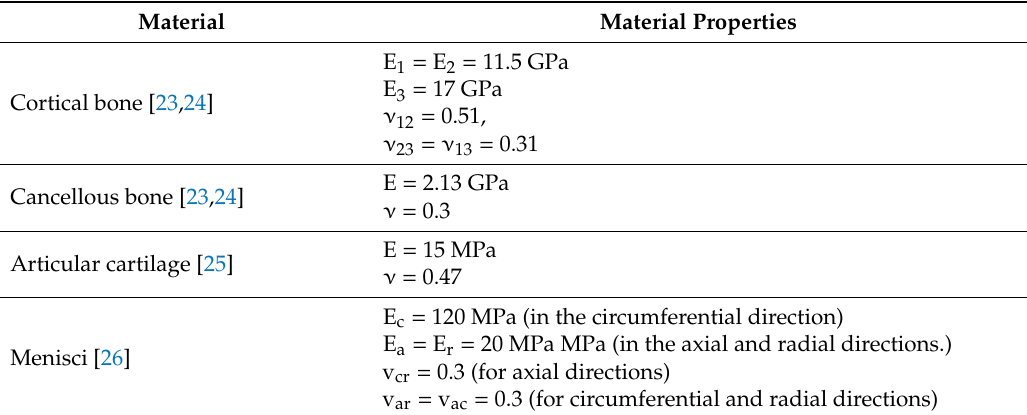
Table 1. Material properties for the 3D FE knee joint model.